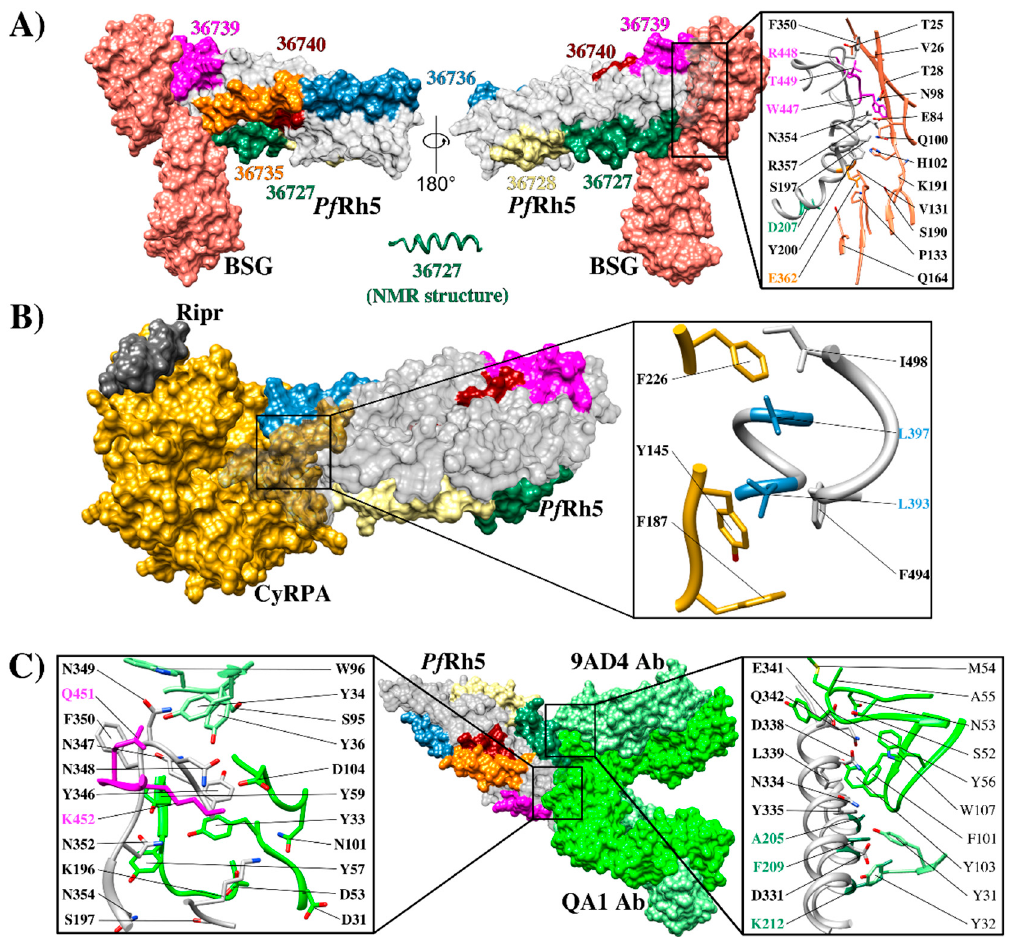
Figure 5. Pf Rh5 structure and its interactions ( A ) Structure of the interaction between Pf Rh5-BSG (PDB 4U0Q) [74], highlighting HABP binding to RBC: 36727 (green), 36728 (yellow), 36735 (orange), 36736 (blue), and 36740 (brown). HABP 36727 structure (green) determined by nuclear magnetic resonance (NMR), zooming in on residues in the interaction interface; pink shows HABP 36739 residues 448 R, 449 T, and 447 W (close to HABP 36740), green HABP 36727 207 D and yellow HABP 36735 362 E; ( B ) Crystallographic structure of the Ripr, CyRPA and Pf Rh5 ternary complex in contact with the BSG receptor (PDB 6MPV) [76], zooming in on the residues belonging to the interaction interface between Pf Rh5-CyRPA, HABP 36736 aa 393 L, and 397 L shown in blue; ( C ) Rh5 crystallographic structure, showing points of contact with mAbs QA1 (PDB 4U1G) [74] and 9AD4 (PDB 4U0R) [74] highlighting HABP 36739 residues 451 Q and 452 K in pink and HABP residues 36727 205 A, 209 F, and 212 K in green.